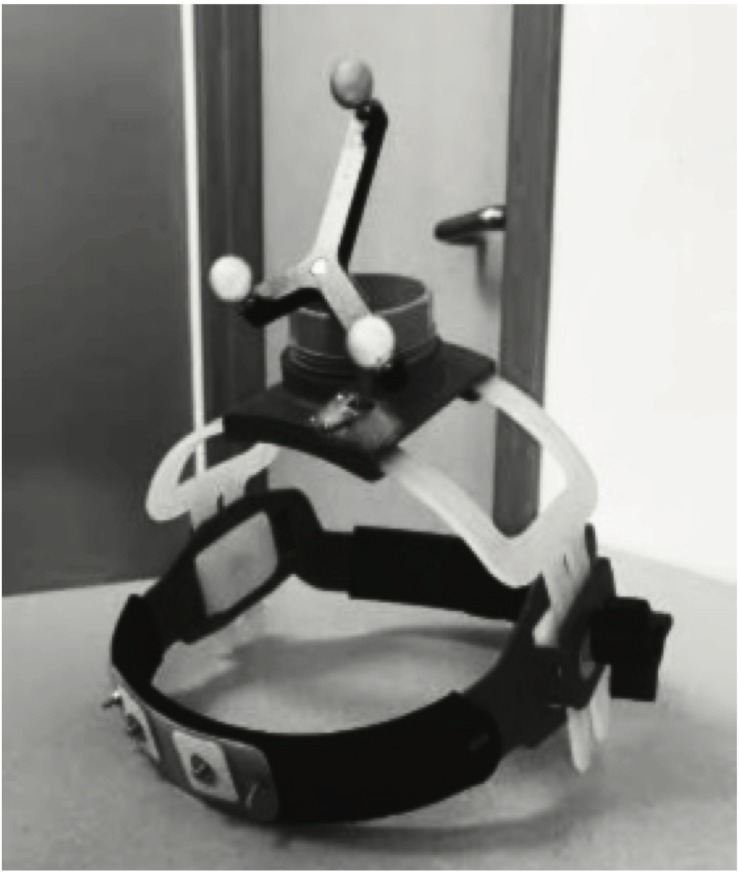
Custom-Engineered tSMS Helmet. Custom designed and partially 3-D printed helmet used for application of tSMS with neuronavigation.